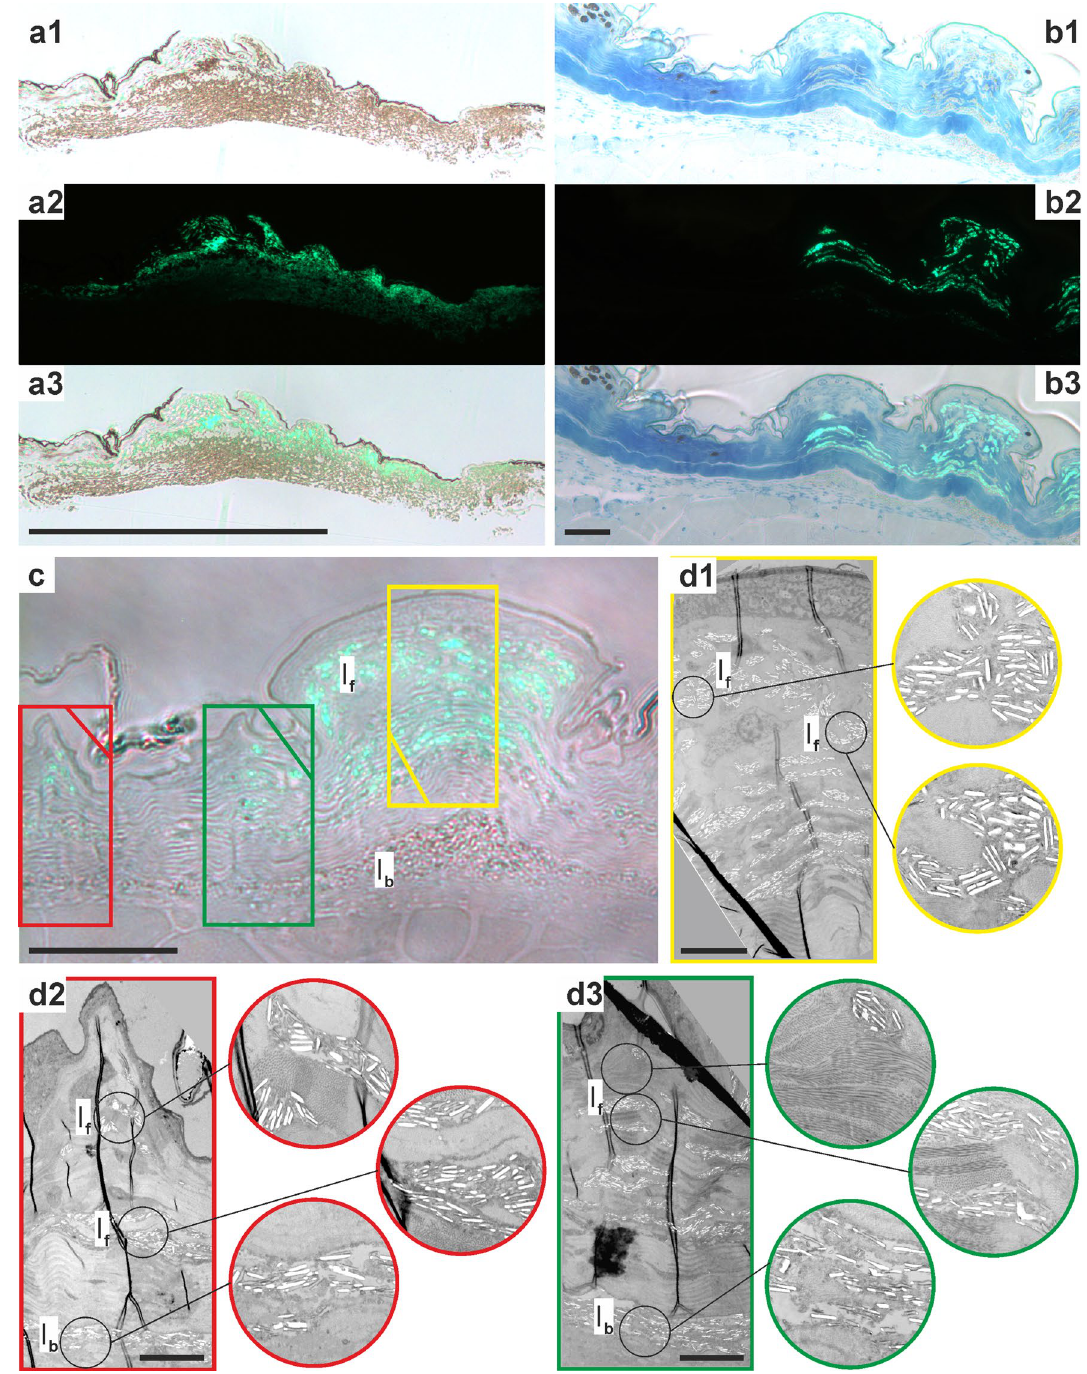
Figure 4. Distribution of iridophores in the dermis of Pachydactylus rangei. ( a ) Sections from skin around the eye; ( a1 ) light microscopy (LM) image; ( a2 ) fluorescence microscopy image; ( a3 ) image overlay of a1 and a2 showing the fluorescence of the iridophores in the outer layers; scale bar: 500 µm. ( b ) LM sections from skin of ventrolateral stripe with the transition of non-fluorescent skin including melanophores (left) to fluorescent skin with iridophores (right); ( b1 – b3 ) following ( a1 – a3 ), scale bar: 50 µm; ( c ) section of fluorescent skin from the ventrolateral stripe in LM, scale bar: 50 µm; ( d ) Transmission electron microscopy (TEM) images of the sectors indicated (by colour) in ( c ), with ( d1 ) in yellow, ( d2 ) in red, and ( d3 ) in green; circled images show enlarged iridophores of the respective image top down, scale bar: 10 µm. Note how the non-fluorescent iridophores of the lowest layer are disordered and more loosely packed than the fluorescent iridophores above. I f fluorescent iridophores, I b basal (non-fluorescent)